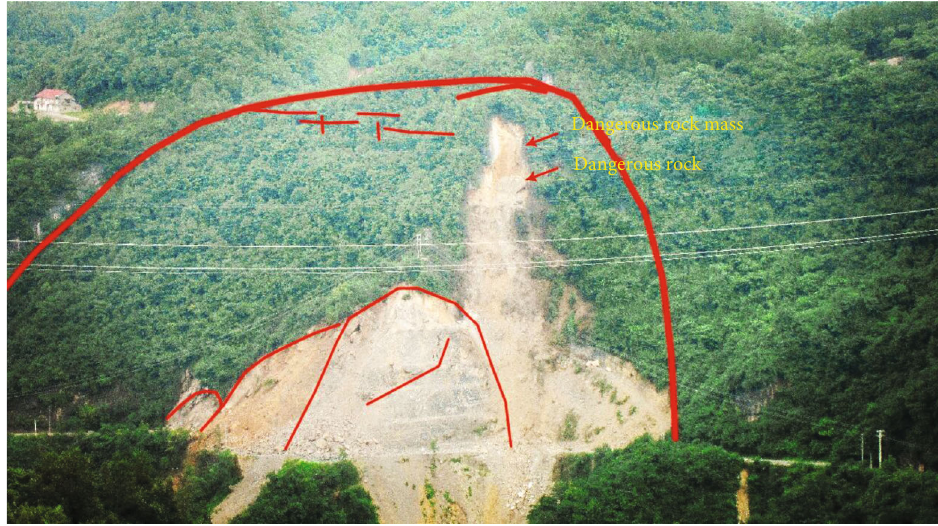
Figure 3: Overall view of Tanziyan